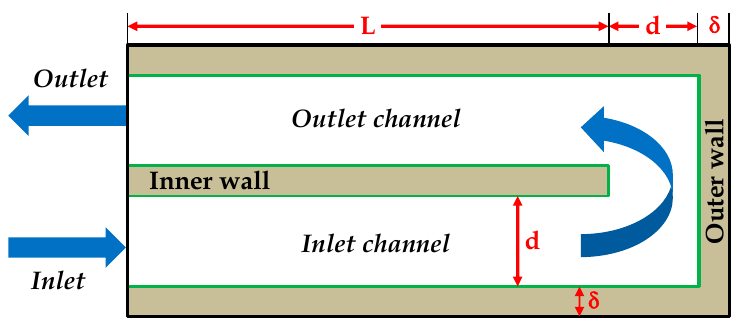
Figure 1. Two-dimensional computational domain (not to scale): U-bend catalytic heat-recirculating micro-combustor. The green lines denote the catalytic surfaces where heterogeneous combustion takes place.